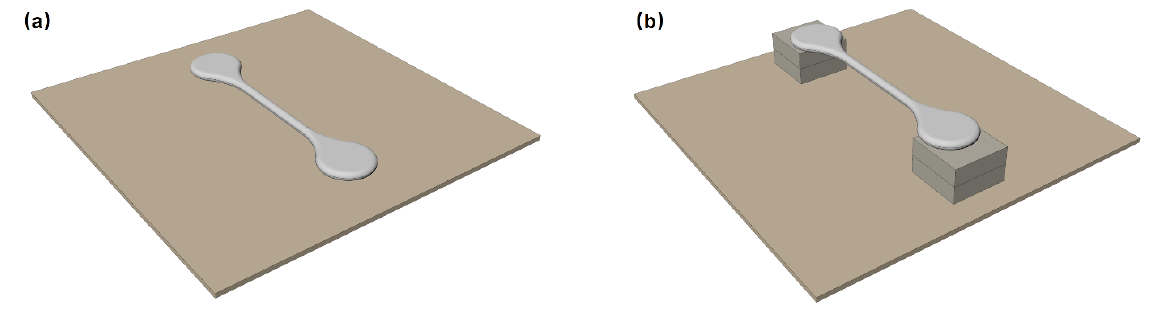
Figure 5. Elongated specimen of Ti-6Al-4V. ( a ) Laid and ( b ) supported.